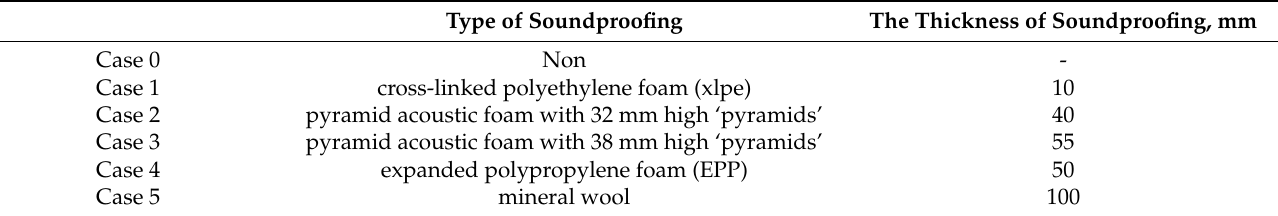
Table 1. The tested type of the